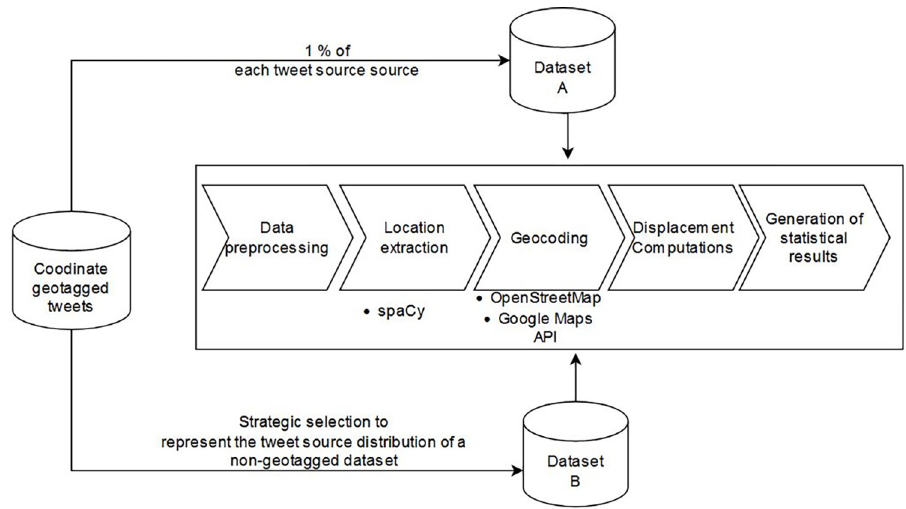
Fig 1. Overall workflow of the proposed